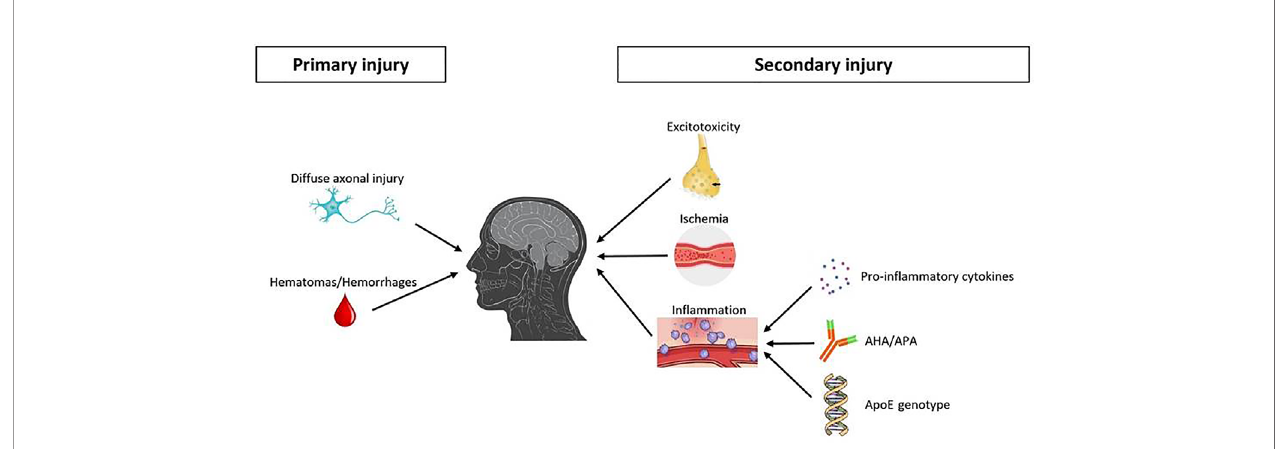
FIGURE 1 | Main pathophysiological mechanisms underlying pituitary damage after TBI. TBI, traumatic brain injury; AHA, anti-hypothalamus antibodies; APA, anti- pituitary